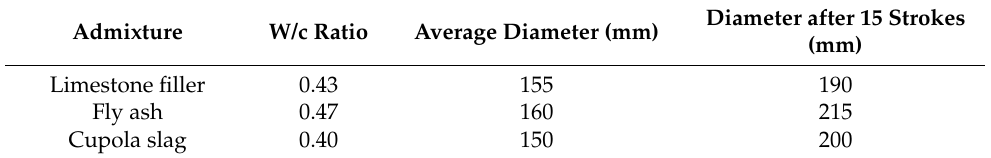
Table 5. Mortar consistency with different